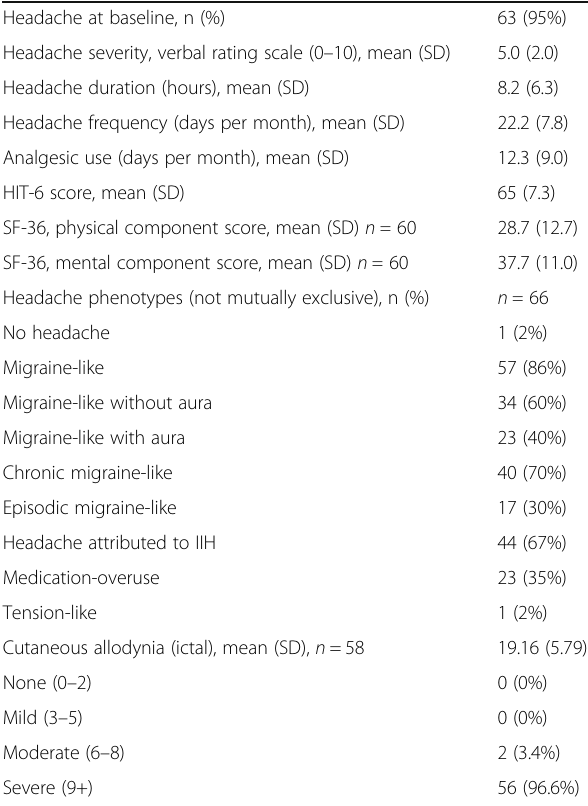
Table 2 Outcome measures, headache phenotype and